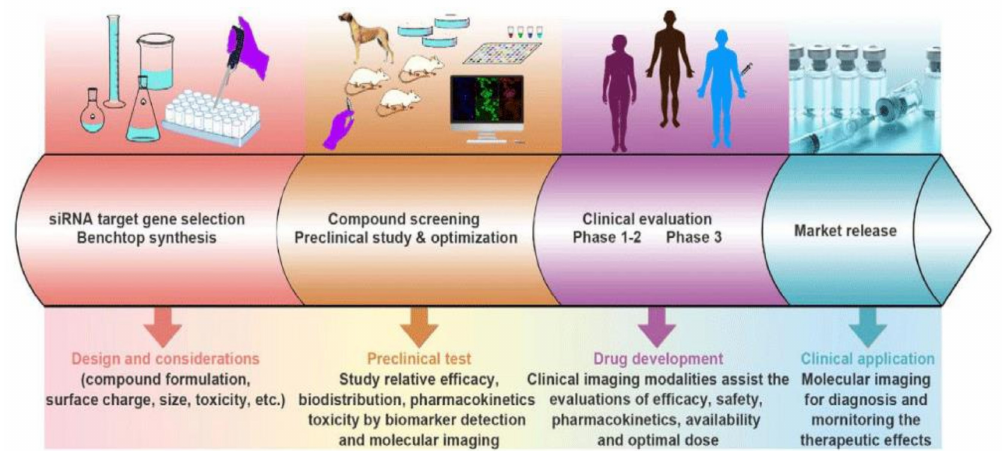
Figure 9. Workflow process of developing RNA-based therapies for clinical applications. Reproduced with permission from Wang, J. et al., Adv Drug Deliv Rev; published by Elsevier, 2016